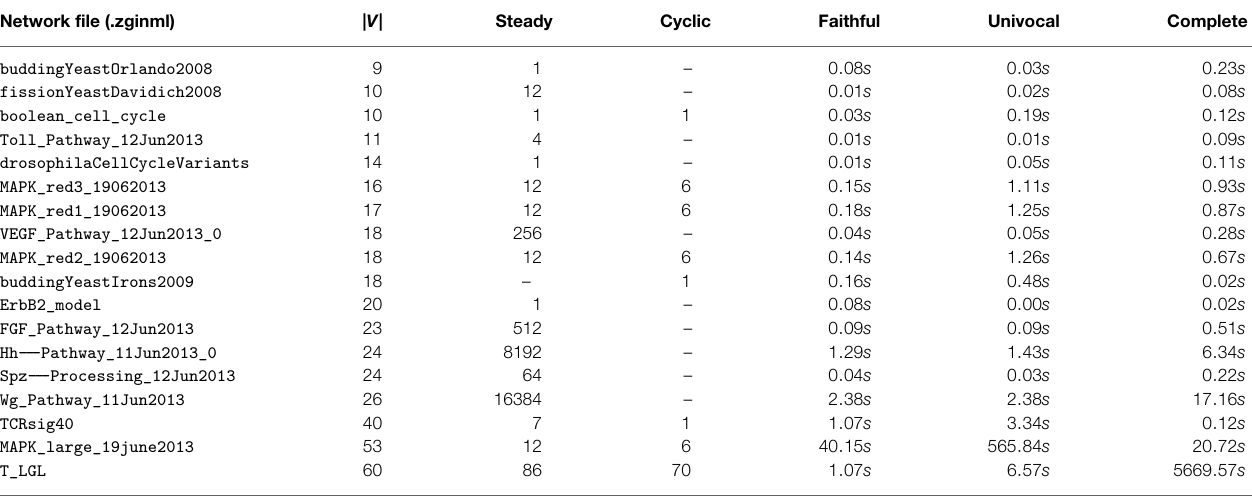
TABLE 2 | The minimal trap spaces of all Boolean models in the GINSIM repository are perfect approximations of the attractors of ( S , ↩ ! ↩ ! ↩ ! ) . Network file